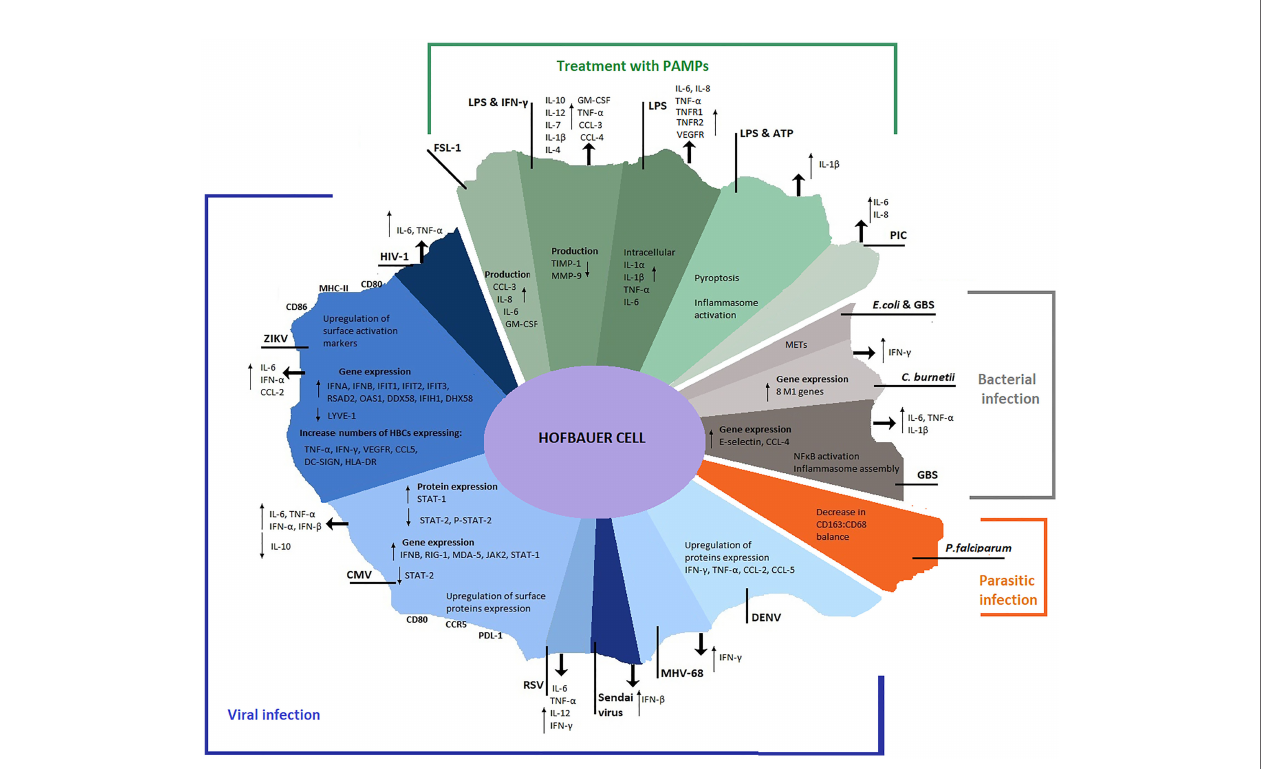
FIGURE 4 | Overview of HBC pro fi le during pathogen infection and PAMP(s) stimulation. Alterations in HBC transcriptional, translational and secretional levels documented after pathogen infection or PAMP(s) treatment in the studies retrieved from the search strategy. Viral infections are represented in blue shades, parasitic infections in orange, bacterial infections in grey and PAMP(s) treatments in green.